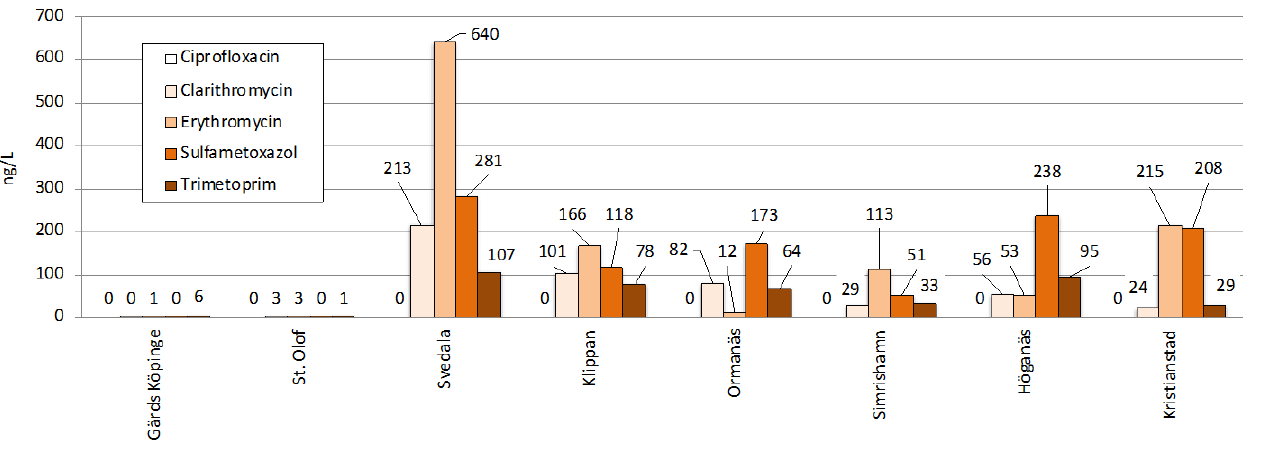
Figure 6. Measured outlet water concentrations (ng/L) of the five antibiotics, namely ciprofloxacin, clarithromycin, erythromycin, sulfamethoxazole and trimethoprim, in the 8 Scanian WWTPs.